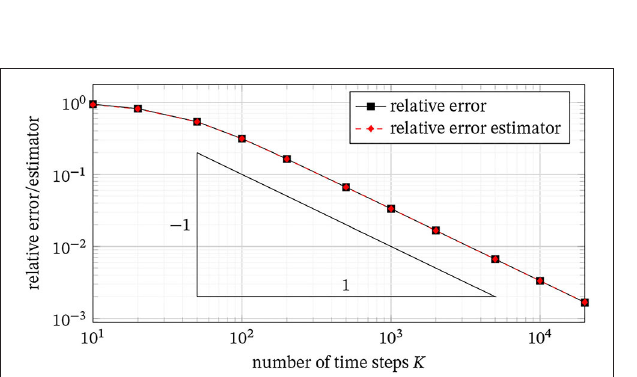
FIGURE 4 | Maximal greedy training error max µ ∈ P resolutions K u = K ∈ { 75,150,300 } over the reduced dimension N .